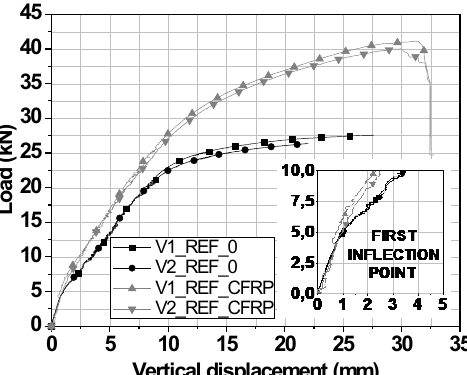
Figure 15. Load versus displacement of reference beams without strengthening and strengthened